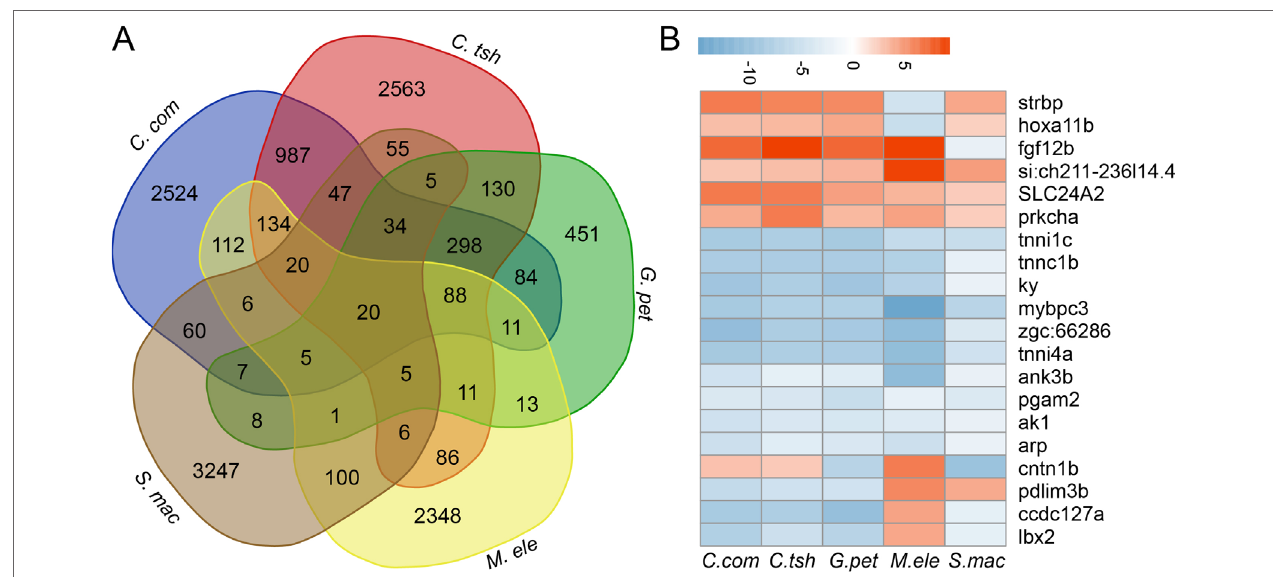
FIGURE 5 | Comparison analysis of DEGs between SM and EO tissues among five electric fishes. (A) Venn diagram of DEG (differentially expressed between EO and SM) among five electric fishes. The number in the figure represents the DEG number. Venn diagram analysis was conducted by online tool (http://bioinformatics. psb.ugent.be/webtools/Venn/). (B) The illustration shows the log2 fold change of 20 shared DEGs across the five focal species (red, upregulated in EOs, and blue, downregulated in EOs).